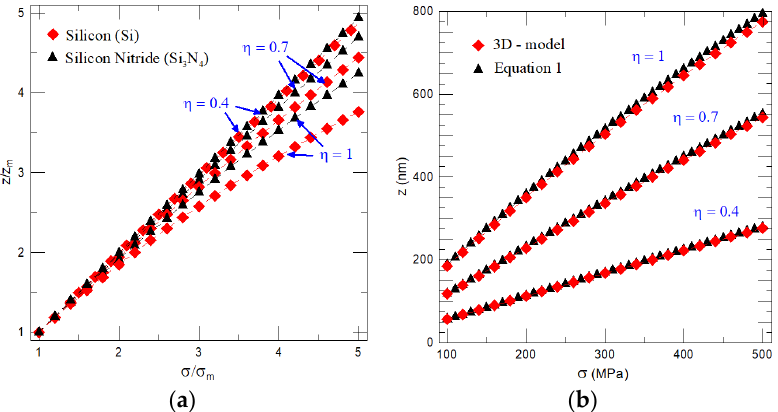
Figure 3. ( a ) Change in relative deflection z / z m as a function of the temperature dependent tensile interlayer stress for different thickness ratios η ; ( b ) estimated static deflections of the cantilever made of Si 3 N 4 of L = 6 μ m, W = 900 nm and T 1 = 250 nm for three different NiTi film thicknesses as a function of the temperature dependent interlayer stress calculated by Equation (1) and the 3D model.